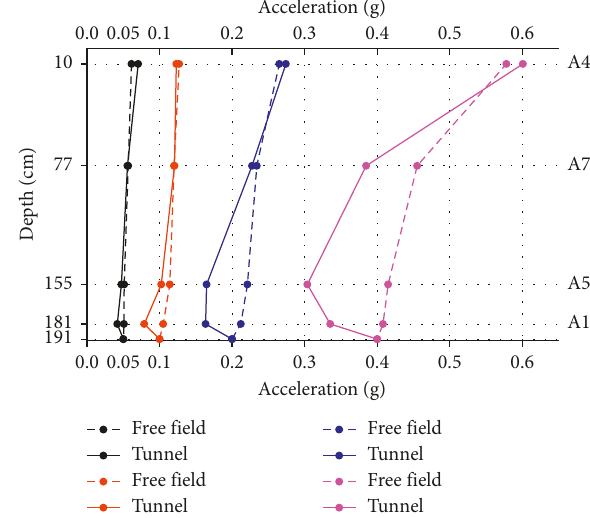
Figure 8: Profiles of maximum acceleration with Kobe